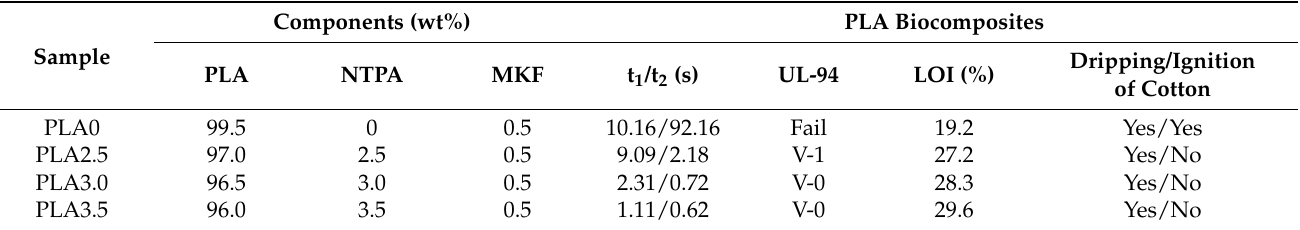
Table 1. Formulation and the UL-94 and LOI test results of the PLA/MKF/NTPA biocomposites.